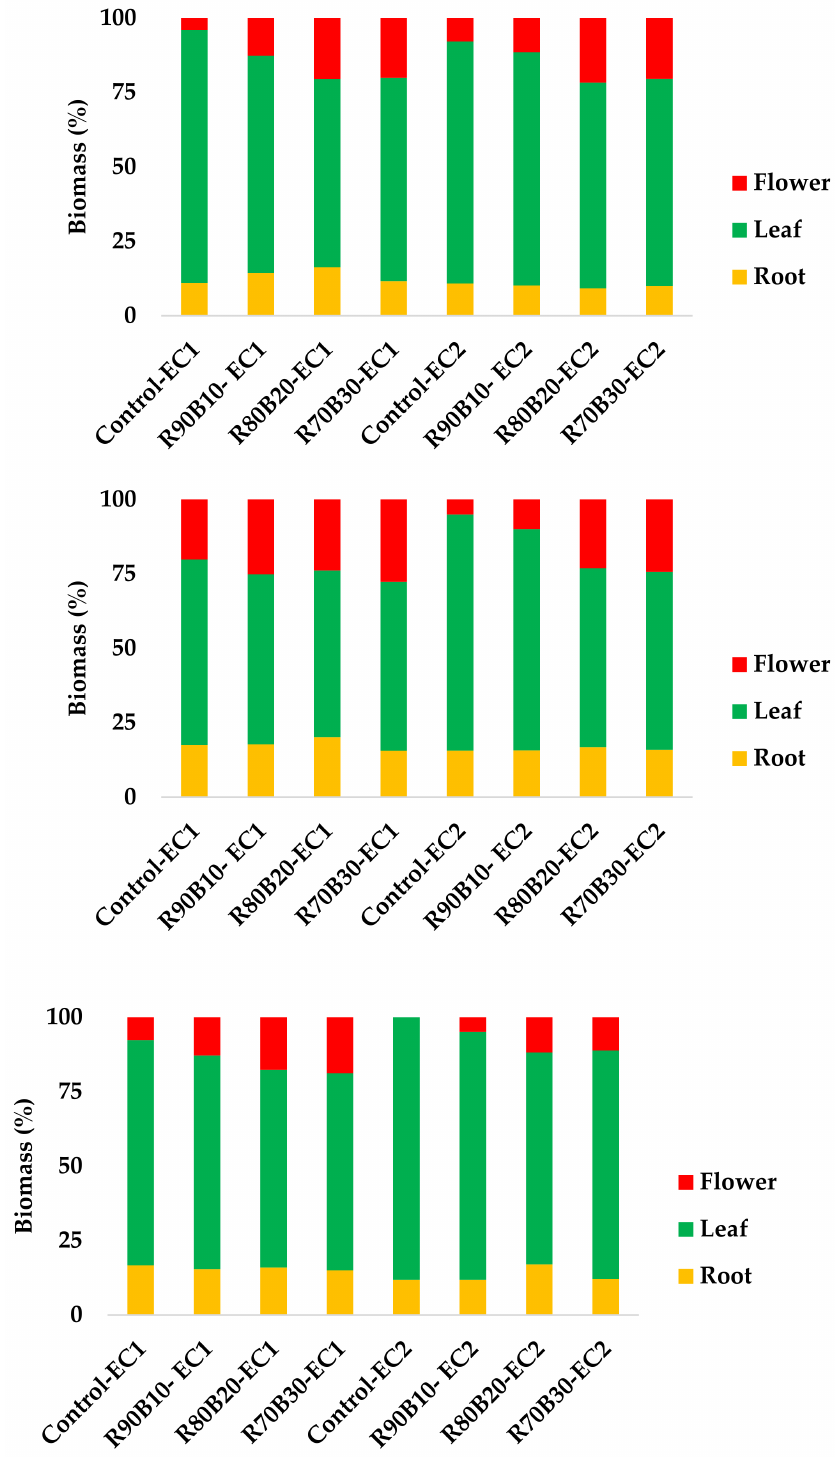
Figure 2. Effect of supplementary light and nutrient solution electrical conductivity (EC) on biomass partitioning of Aechmea ‘Primera’ ( top panel), Guzmania ‘Rostara’ ( middle panel), and Vriesea ‘Splen- riet’ ( bottom panel) plants. The light treatment included control (no supplementary light), R90B10 [90% red (R) and 10% blue (B)], R80B20 (80% R and 20% B), and R70B30 (70% R and 30% B), while the EC values employed were 1 and 2 dS m − l . Four replicate plants were assessed per treatment. Statistics are provided in Table